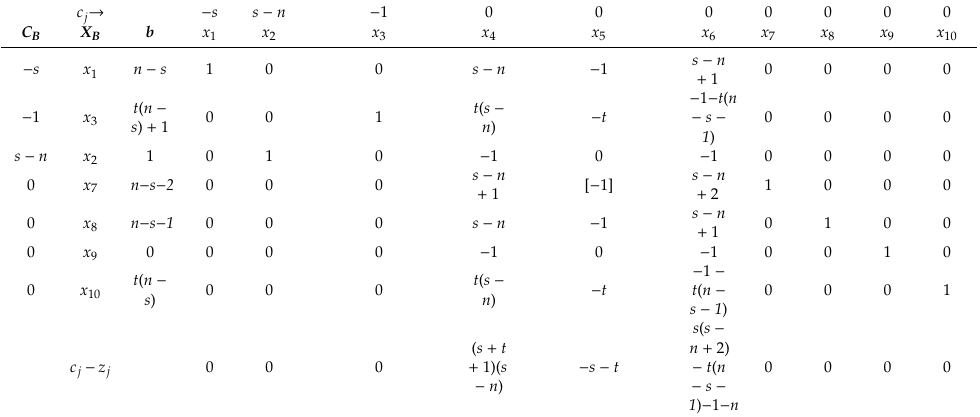
Table 6. Simplex table of IPM II for Case 3 after three iterations.